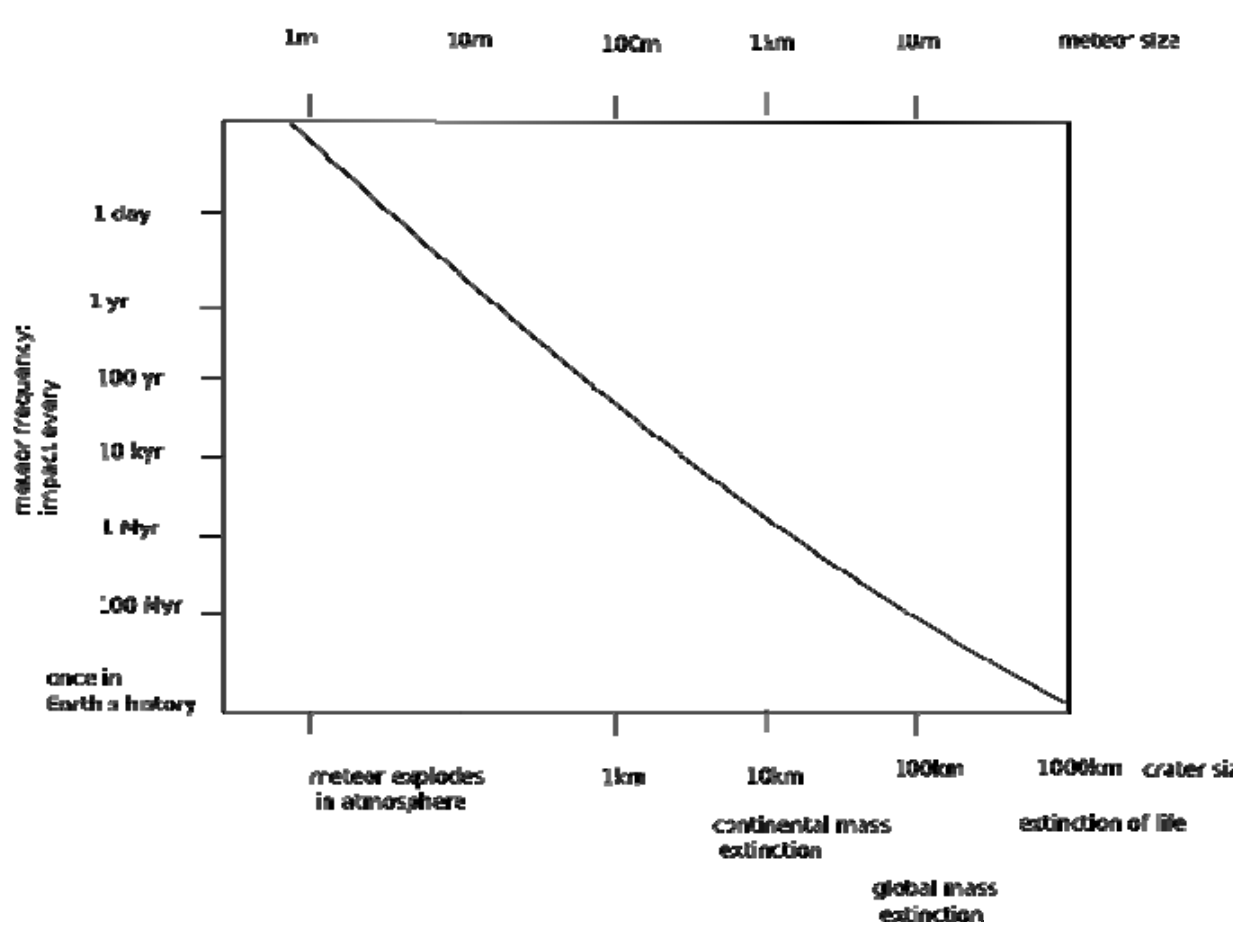
Figure 3. The relation of the size of a meteorite to the damage it would cause. Data from